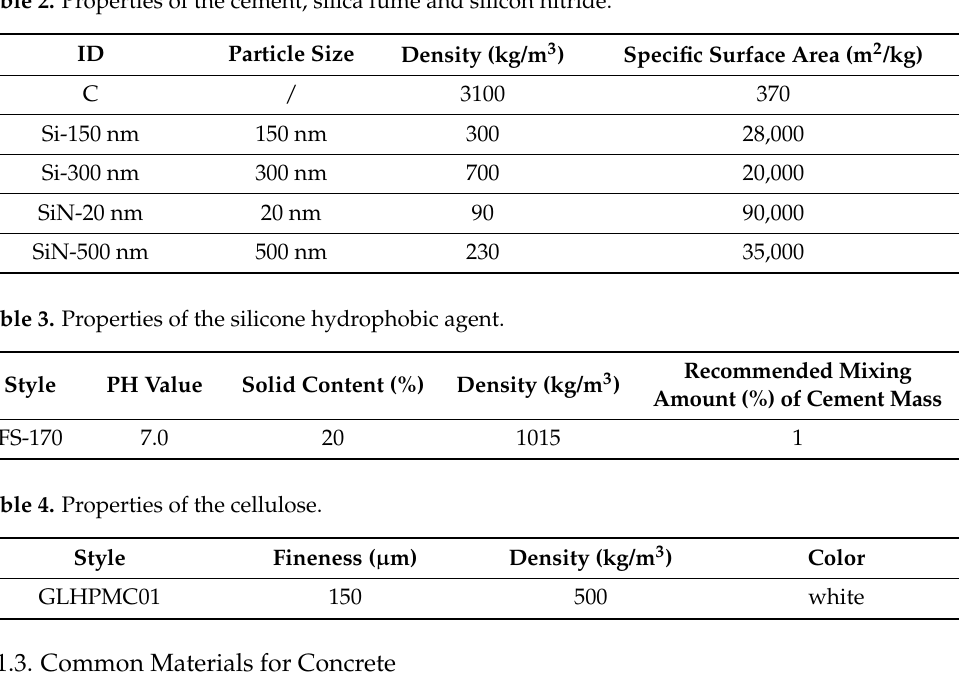
Table 2. Properties of the cement, silica fume and silicon nitride.